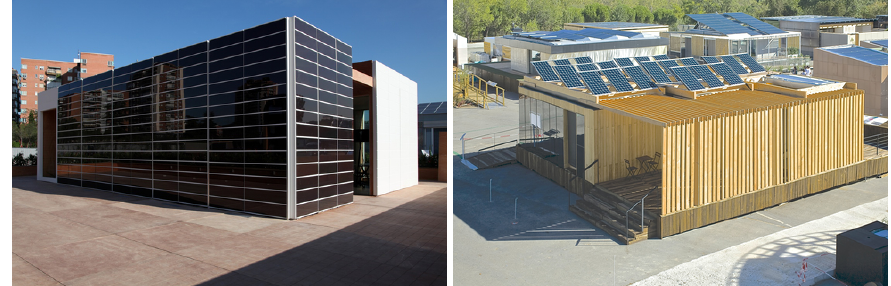
Figure 11. Solar-powered houses: SMLhouse ( left ) and SMLsystem ( right ).